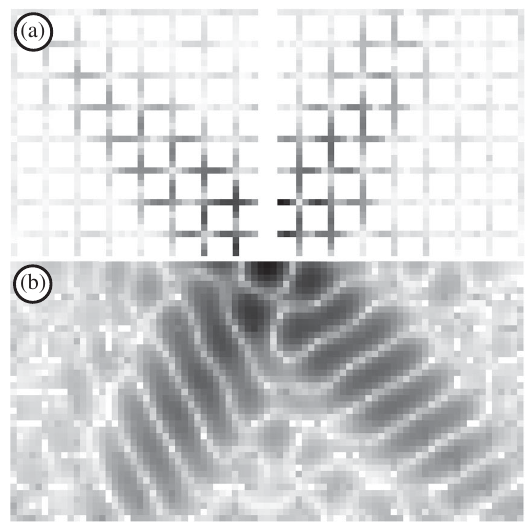
FIG. 7. The down-sampled mesh of intensities used as intensity constraints during phase iterative retrieval (a), and the combined intensity constraints and retrieved floating values (b). Intensities are displayed on a logarithmic